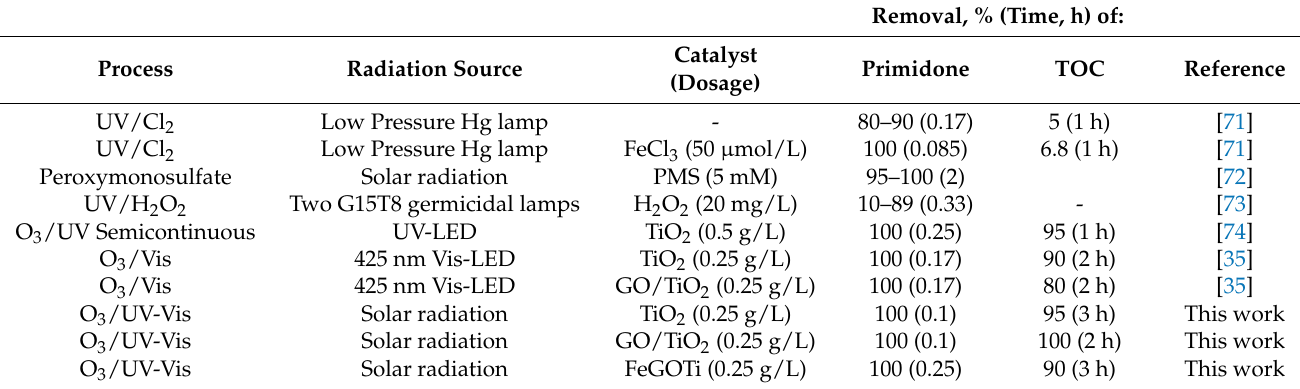
Table 5. Main values reported for primidone AOP